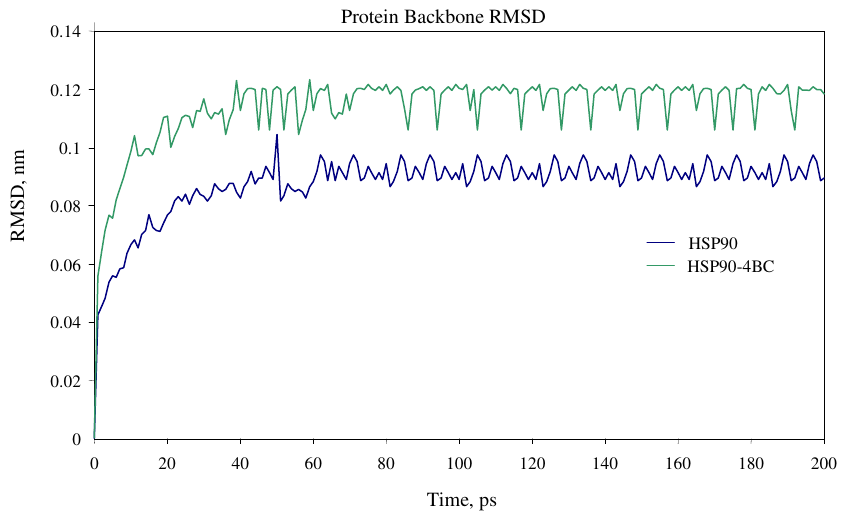
Figure 3. Root-mean-square deviation (RMSD) of Hsp90s backbone without blocker ( ), and in the presence of the inhibitor, 4BC